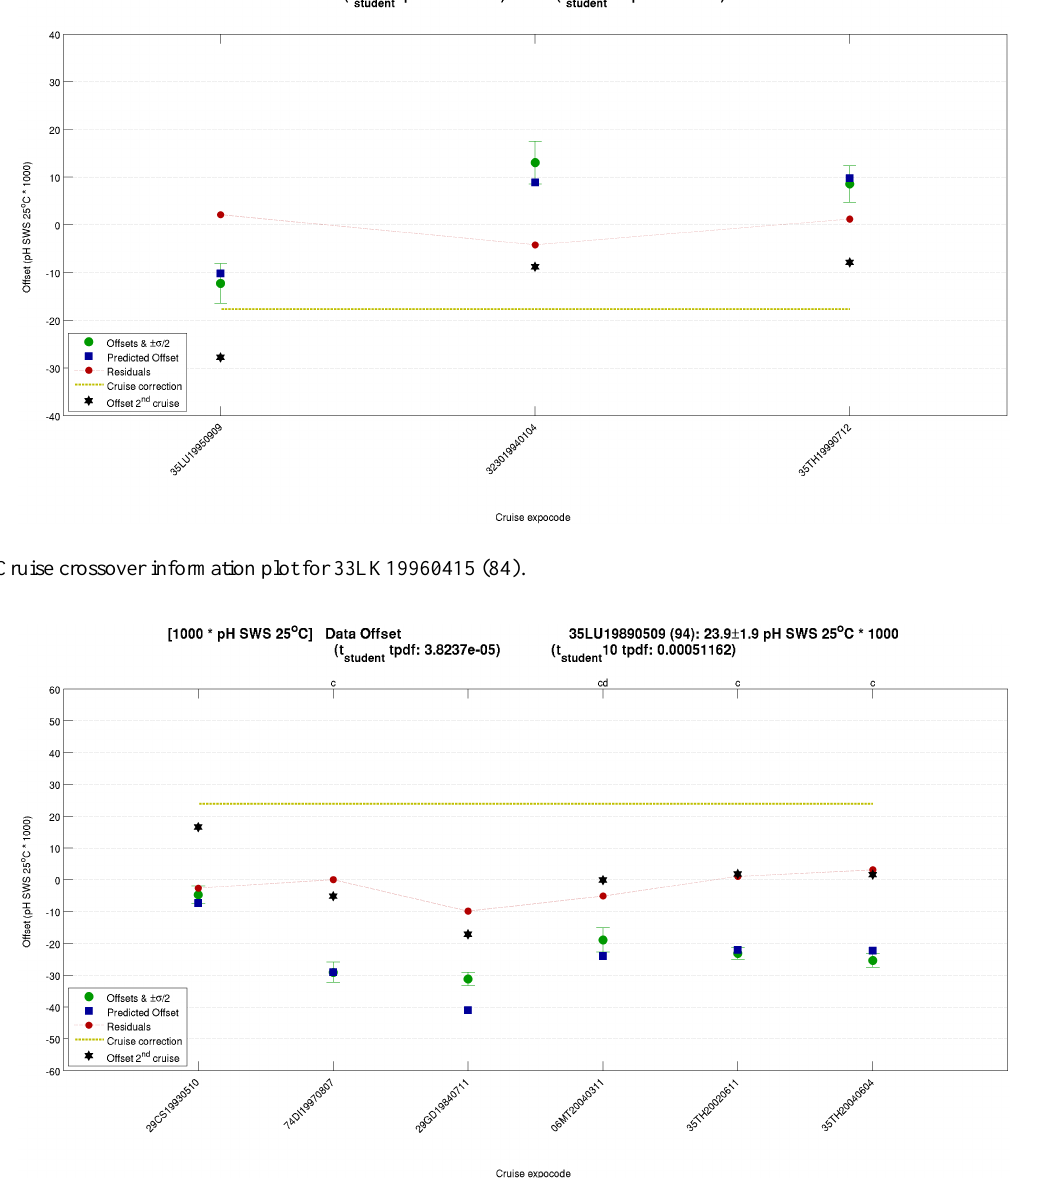
Figure 15. Cruise crossover information plot for 35LU19890509